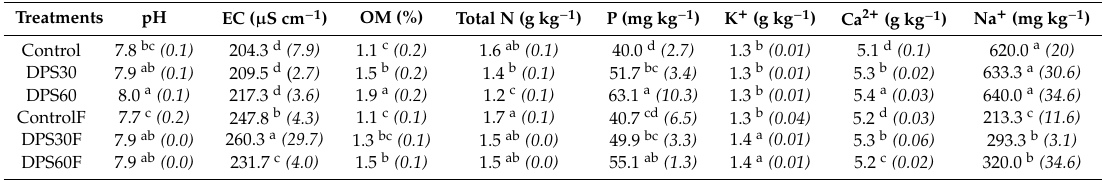
Table 2. Means and standard deviations (italicized and in parentheses) for the analysis of variance of soil chemical properties as related to treatment with deinking paper sludge (DPS) at 0, 30, and 60 Mg ha − 1 after two annual DPS applications (with ammonium nitrate fertilizer F or